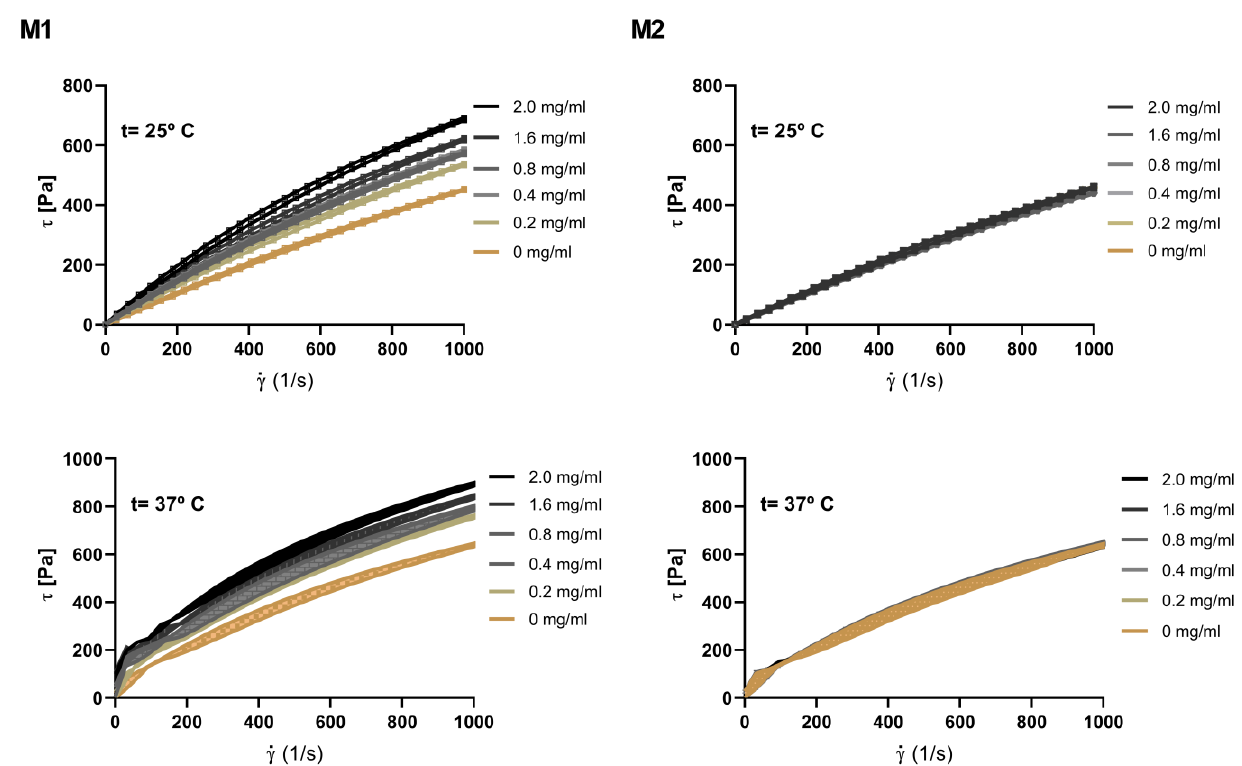
Figure 8. Hysteresis loop tests of P407 18% Casein 10% hydrogel at different concentrations of the TBH-PCL nanoparticles to (M1) and (M2) at 25 ◦ C and 37 ◦ TBH-PCL nanoparticles to (M1) and (M2) at 25 °C and 37 °C.